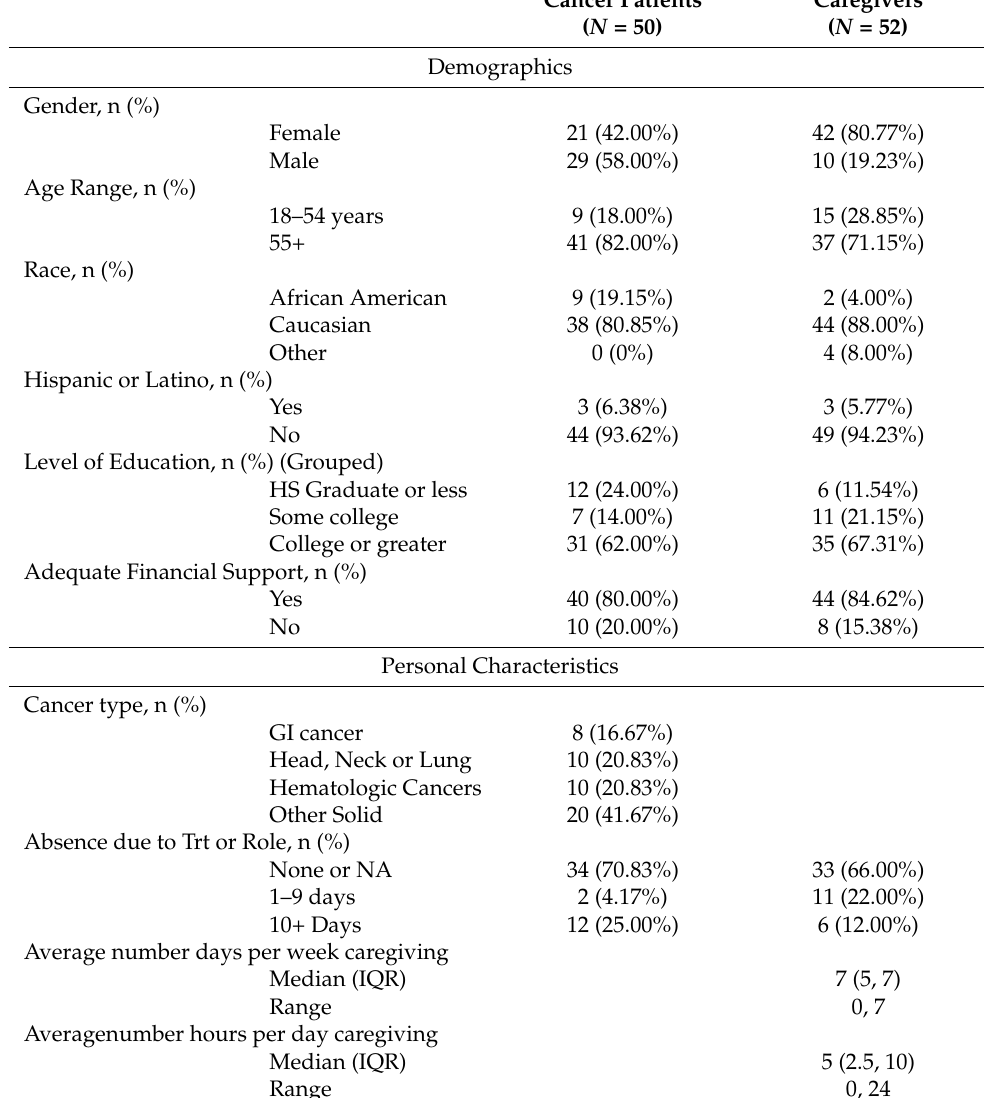
Table 1. Participant demographic and personal